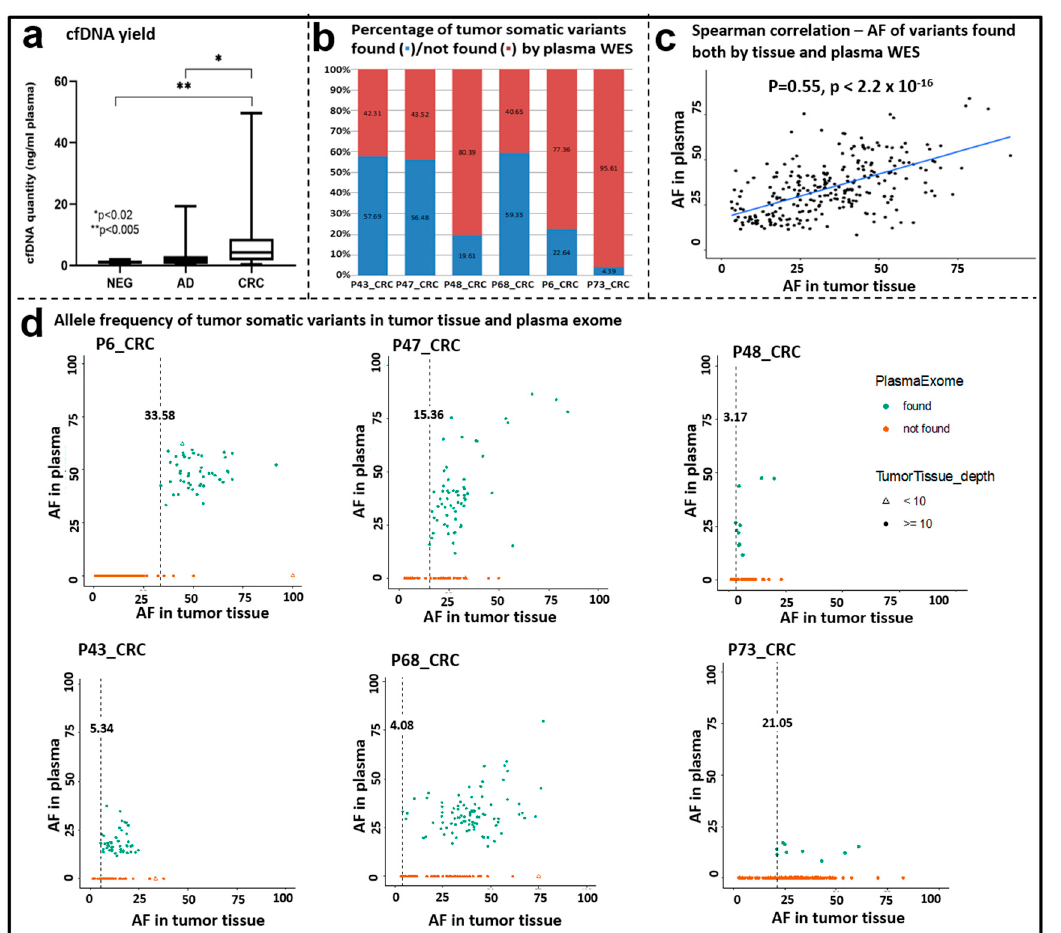
Figure 6. Comparison of tissue and plasma exome sequencing data. ( a ) cfDNA quantity (ng/mL plasma) in the NEG, AD, and CRC groups. Boxplot whiskers represent 2.5–97.5 percentiles, and the center line represents the median. * p < 0.02, ** p < 0.005. ( b ) Percentage of tumor somatic variants found/not found by plasma cfDNA WES. ( c ) Correlation of the allele frequency data of somatic variants detected both in tissue and plasma samples by WES. Spearman correlation ρ = 0.55, p < 2.2 ×